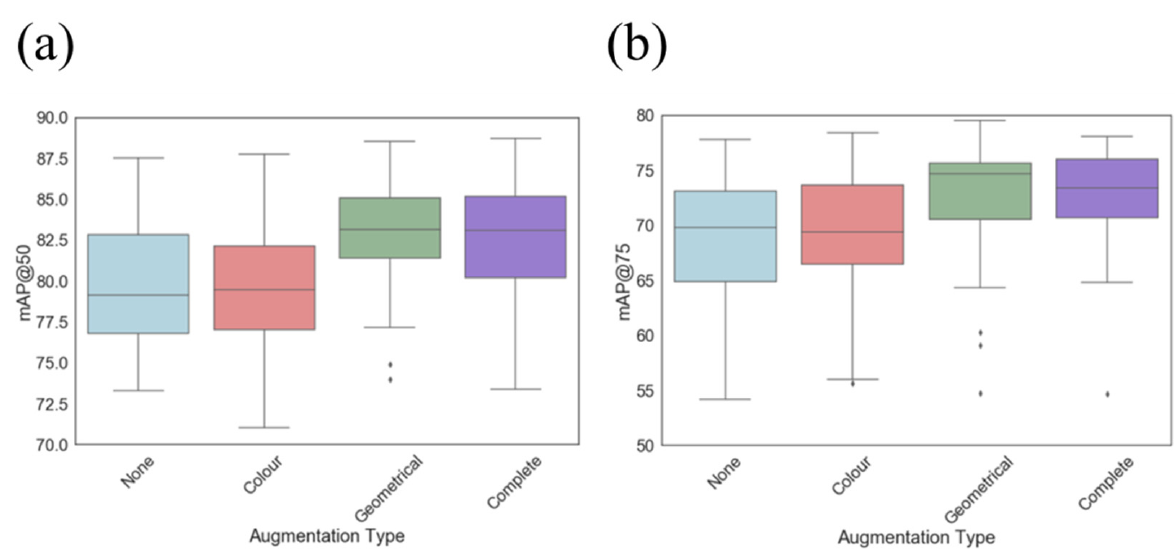
Figure 10. Box plot for image performance with and without augmentation transforms active.( a ) mAP@50; ( b ) mAP@75.